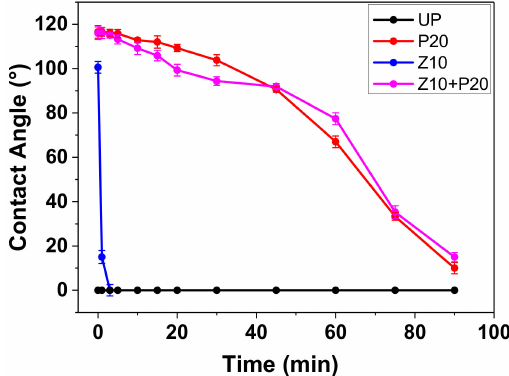
Figure 13. The contact angle of the untreated and sputtered